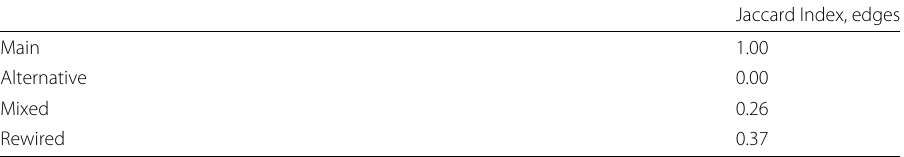
Table 3 Edge similarity, compared to the Main